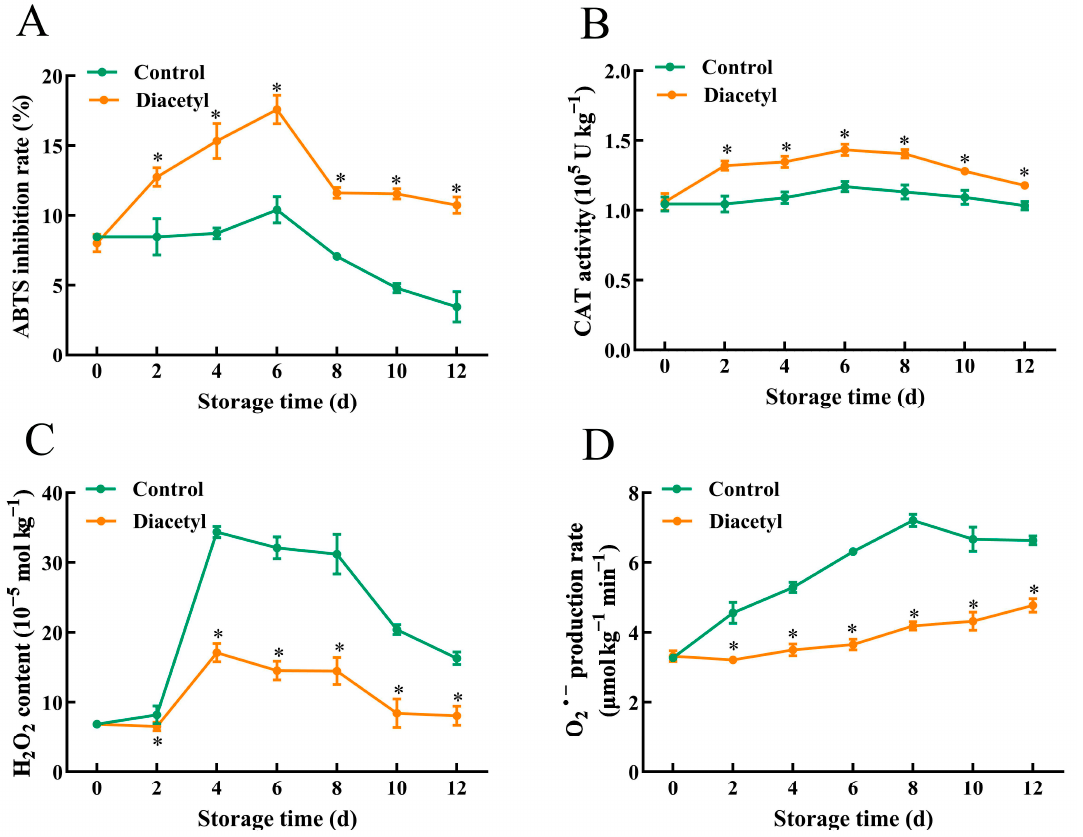
Figure 5. Diacetyl improved the antioxidant capacity of fresh-cut stem lettuce slices during storage time at 4 °C. ( A ) ABTS inhibition rate. ( B ) CAT activity. ( C ) H 2 O 2 content and O 2• − content ( D ). Asterisks * indicate the significant differences ( p < 0.05) between control and treated groups in the figure at the same storage time. Vertical bars represent standard deviations.